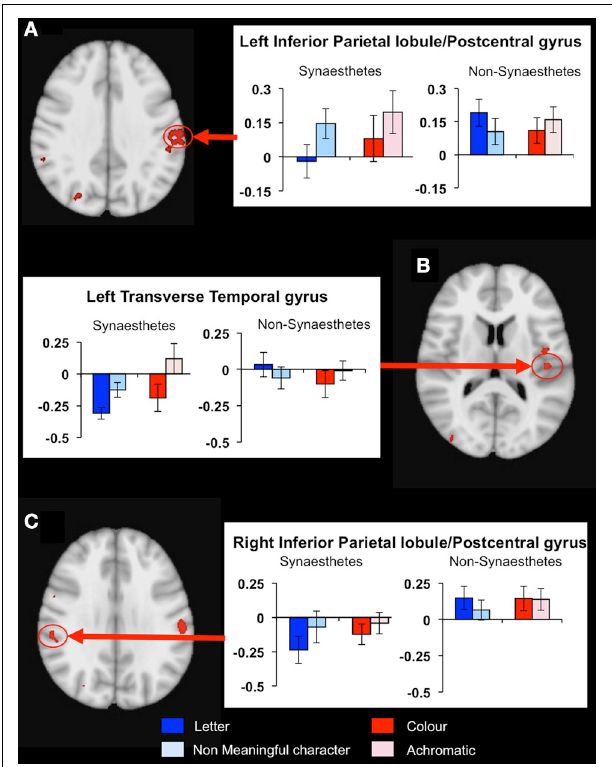
FIGURE 5 | Results from the whole-brain voxelwise ANOVA for the letter/non-meaningful character contrast. Three clusters showed a significant group x condition interaction and a main group effect in response to letters. Mean fMRI task activations within these clusters are detailed for each task condition (letter/character and color/achromatic) in synaesthetes and controls. In each case, synaesthetes show a mean negative BOLD response to letters. (A) Left inferior parietal lobule/post-central gyrus; (B) left transverse temporal gyrus; (C) right inferior parietal lobule/post-central